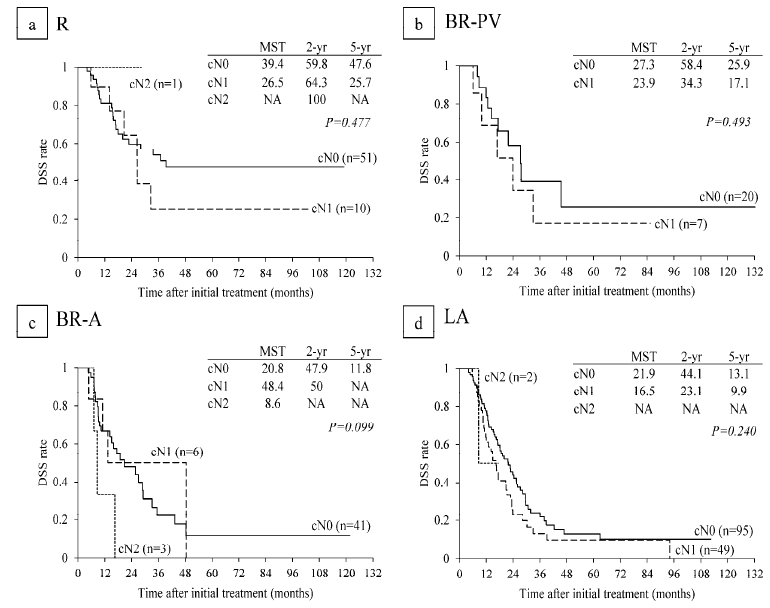
Figure 5. Disease-specific survival (DSS) curves according to serum CA 19-9 level in ( a ) R (n = 57); ( b ) BR-PV (n = 26); ( c ) BR-A (n = 49); and ( d ) LA (n = 139) in the re-evaluated patients excluding the 13 patients whose CA 19-9 level was 1 or less U/mL (n = 272) (cut-off value of CA 19-9 is 500 U/mL). R: resectable, BR-PV: borderline resectable (superior mesenteric vein/portal vein invasion alone), BR-A: borderline resectable (arterial invasion), LA: locally advanced, MST: median survival time (months), NA: not applicable.